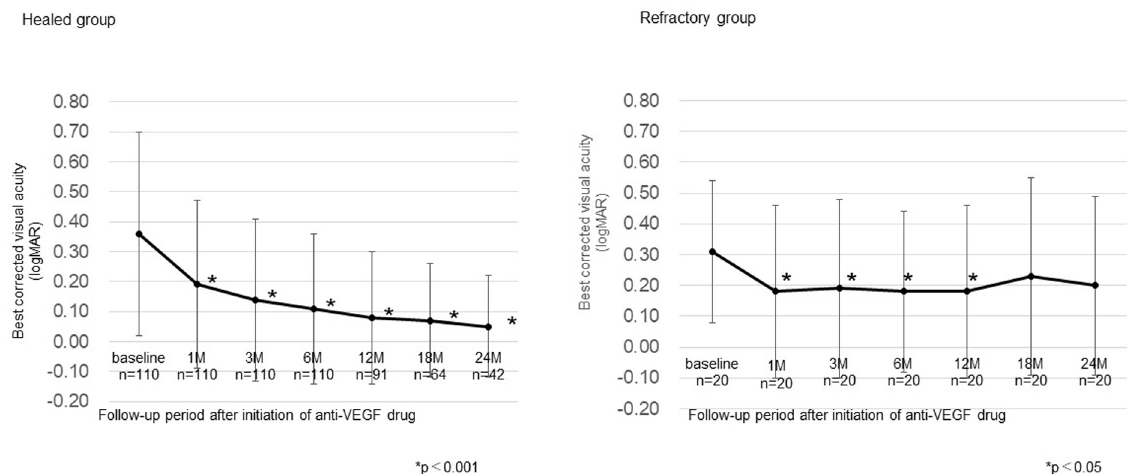
Fig 1. Changes in best corrected visual acuity over the course of treatment until 24 months. In the healed group, best corrected visual acuity (BCVA) improved significantly compared to baseline throughout the treatment period until 24 months. In the refractory group, BCVA improved significantly relative to baseline until 12 months after the start of treatment, and was not significantly different at 18 or 24 months. Data are expressed as mean ± standard